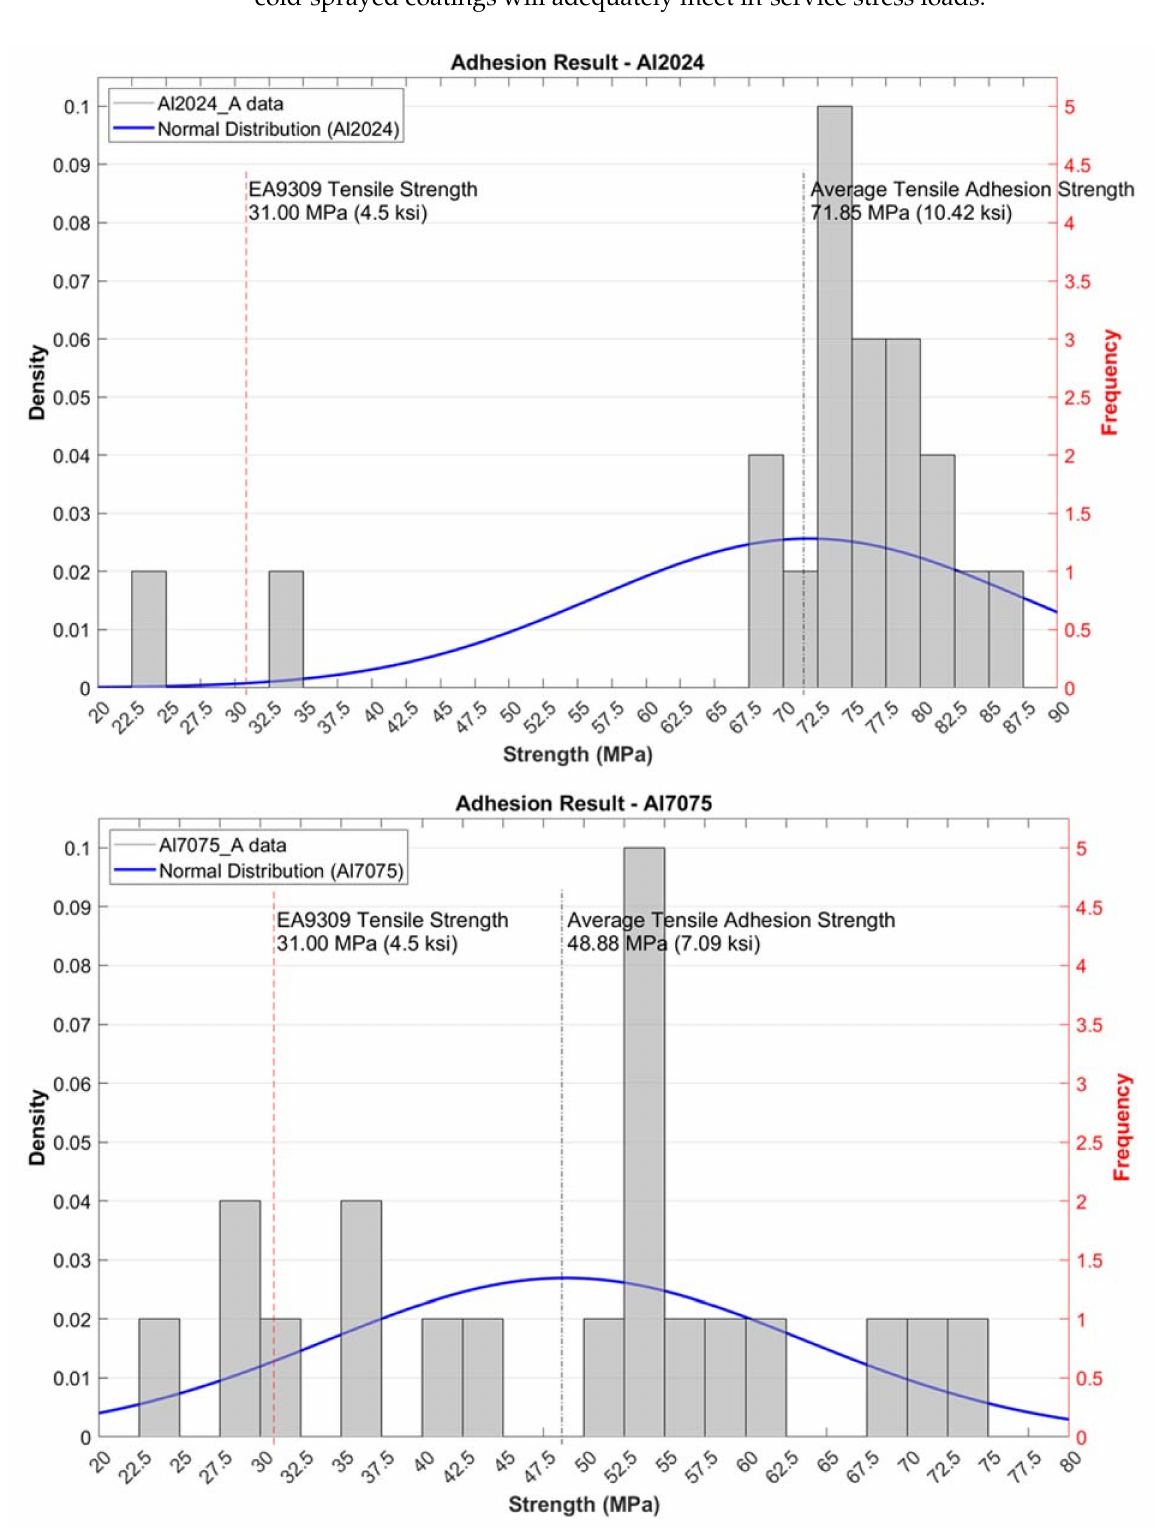
Figure 12. Normal distribution histogram and curve of the tensile adhesive bond strength results of both cold-sprayed Al-2024 and Al-7075